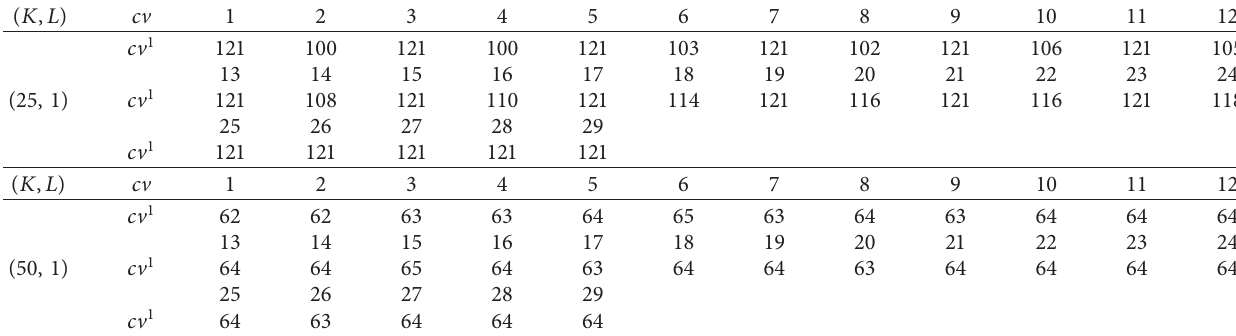
Table 15: Critical values for L �